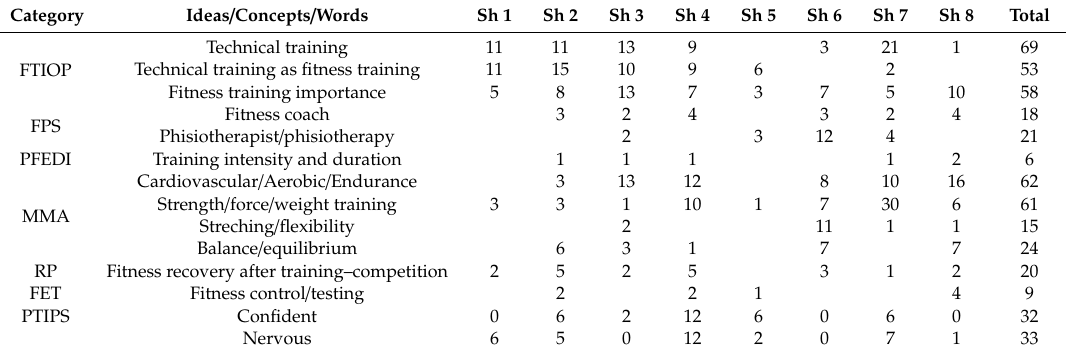
Table 3. Concepts and words most repeated by the athletes interviewed in the fitness area.